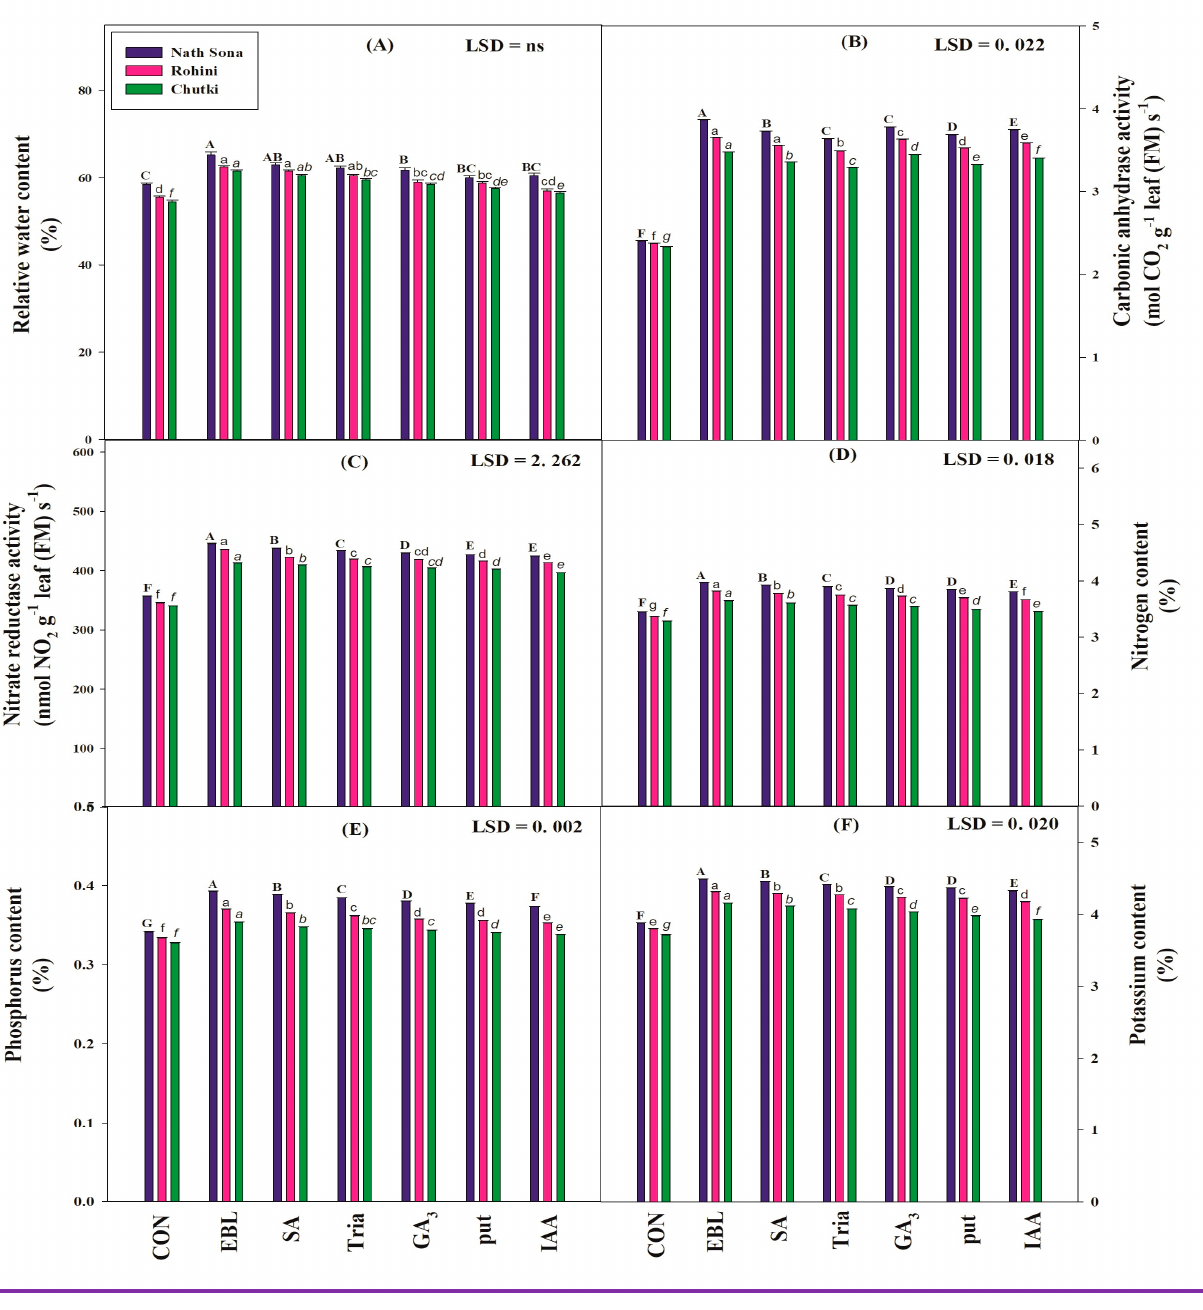
Figure 4. Effect of foliar spray of PGRs on ( A ) Relative water content, ( B ) Carbonic anhydrase activity, ( C ) Nitrate reductase activity, ( D ) Nitrogen content, ( E ) Phosphorous content and ( F ) Potassium content of the mustard cultivars Nath Sona, Rohini and Chutki. Data are treatment means with the standard error (±SE) of four replicates. The different small and capital letters represent a significant difference in three cultivars among various treatments confirmed through Duncan’s Multiple Range test at p ≤ 0.05.